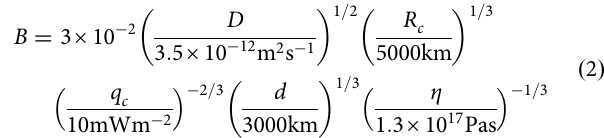
respectively. However, transport properties for bcc ices are quite